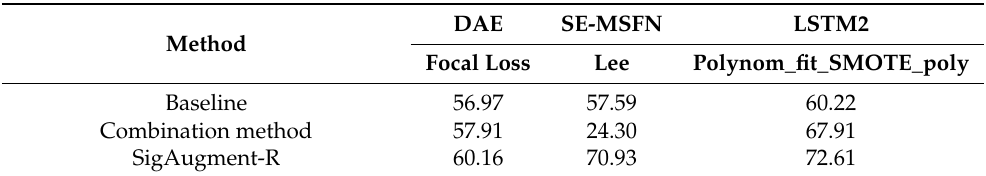
Table 8. Results of the proposed SigAugment method combined with the class rebalancing methods trained on the 2016A-50